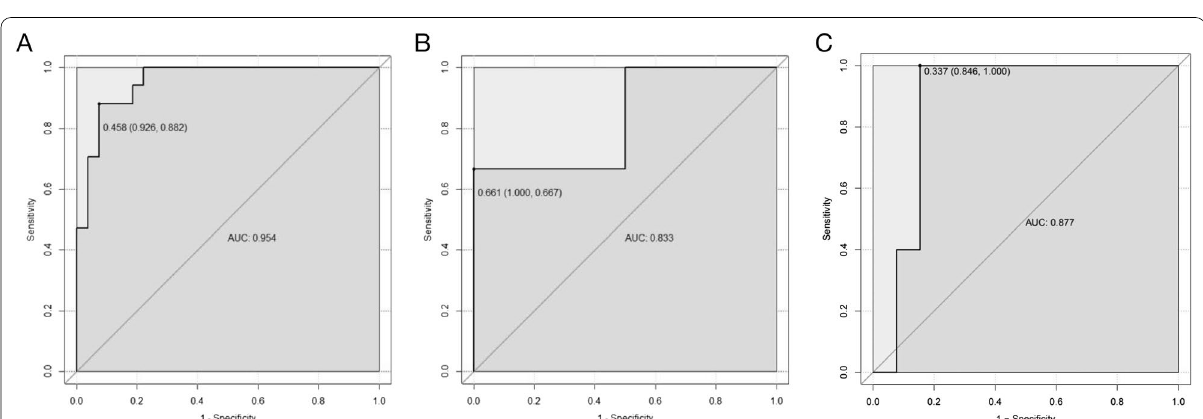
Fig. 4 a ROC curve of the nomogram in the train cohort. The AUC is 0.954. When the cutoff value is 0.458, the specificity is 0.926 and the sensitivity is 0.882. b ROC curve of the nomogram in the validation cohort. The AUC is 0.833. When the cutoff value is 0.661, the specificity is 1.000 and the sensitivity is 0.667. c ROC curve of the nomogram in the validation cohort. The AUC is 0.877. When the cutoff value is 0.337, the specificity is 0.846 and the sensitivity is 1.000. ROC, receiver operating characteristic; AUC, area under ROC